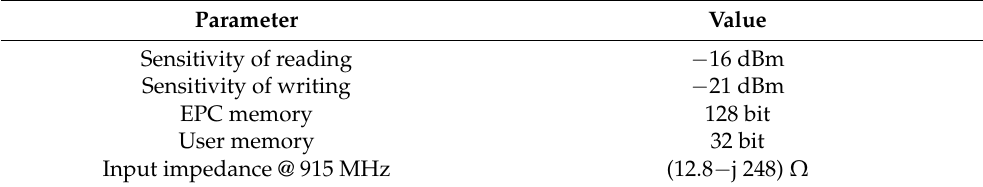
Table 8. Selected parameters of RFID chip: NXP Ucode 7m (SL3S1214).